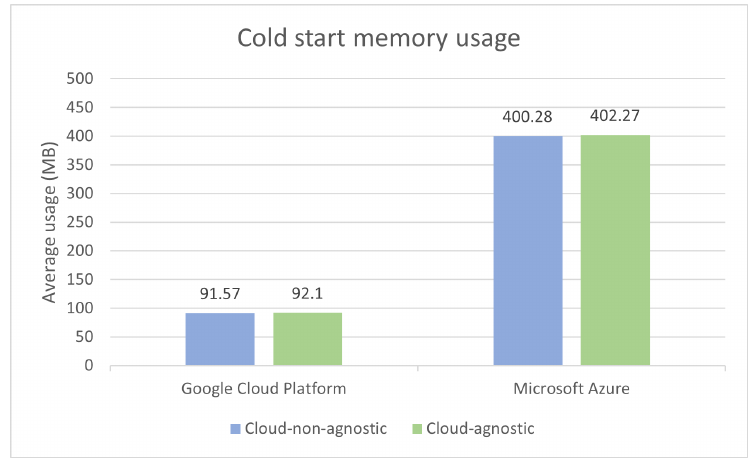
Figure 14. Cold start memory